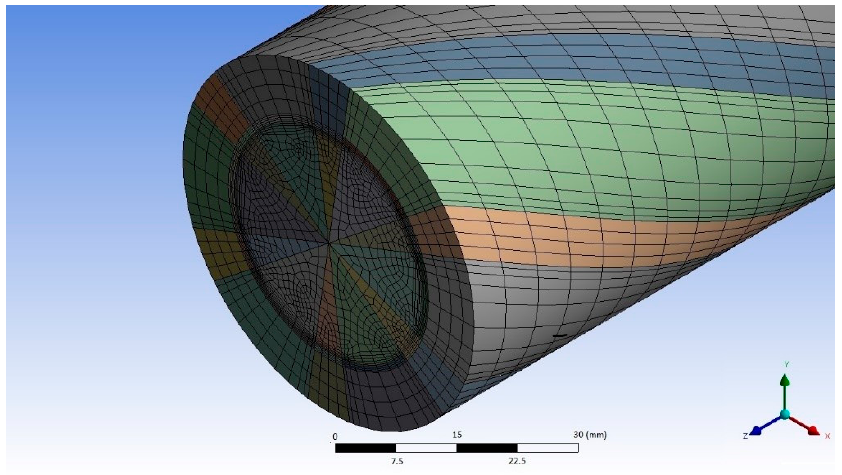
Figure 6. Fragment of the numerical mesh used to calculate the heat transfer coefficient.